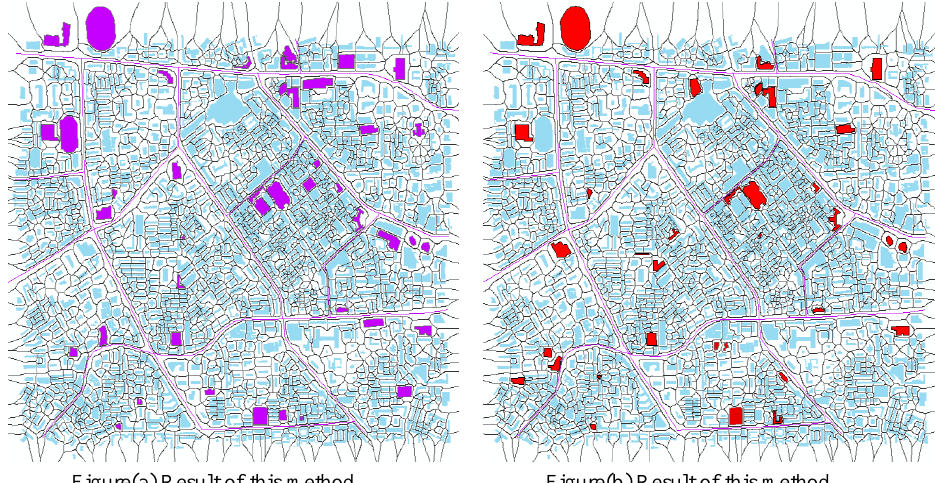
Figure 5.Extracting results of the two methods